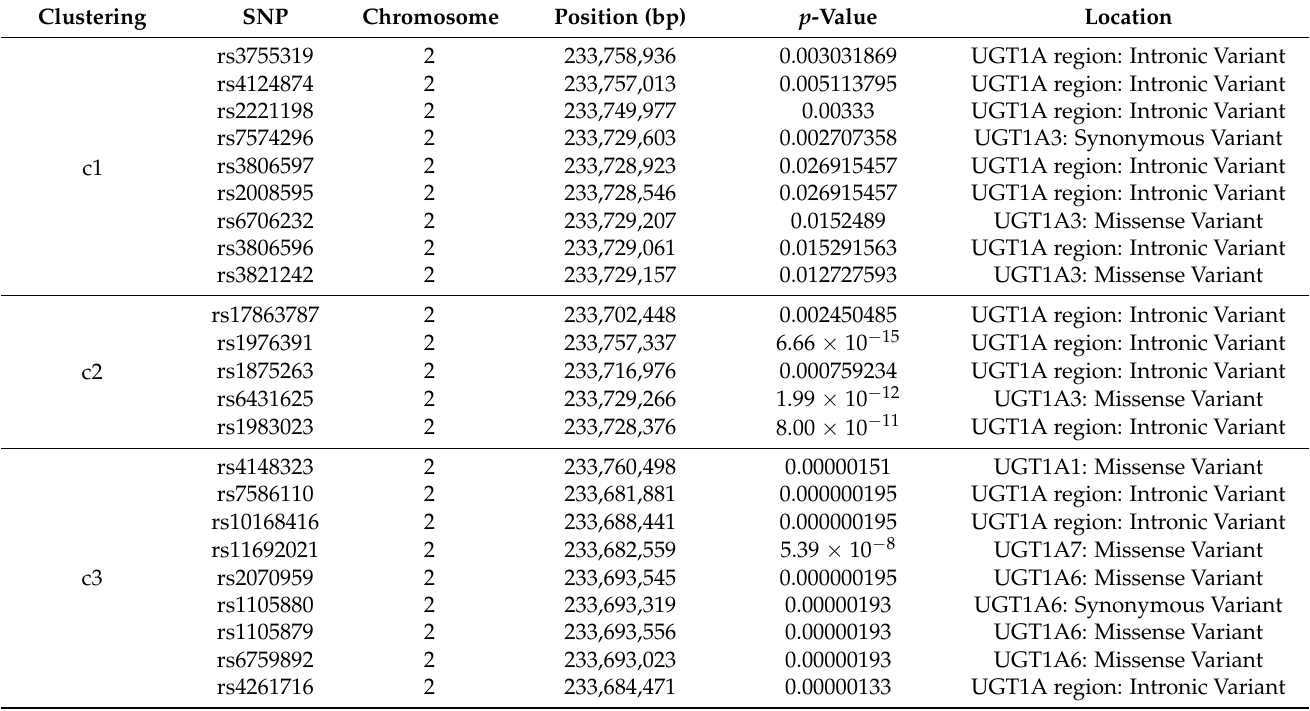
Table 2. The information on SNPs among these tree clusterings which having a high correlation with each